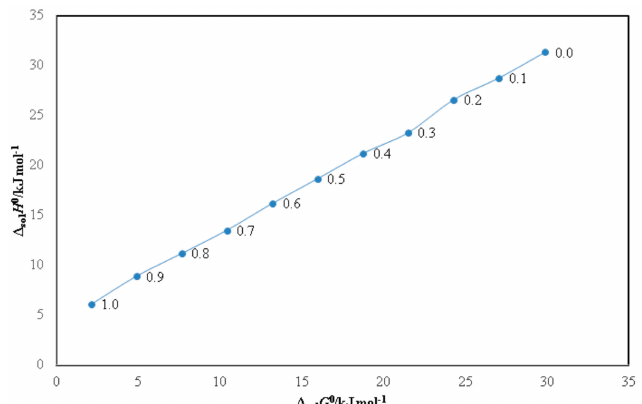
Figure 3. ∆ sol H 0 vs. ∆ sol G 0 enthalpy–entropy compensation plot for solubility of PPD in binary DMSO + water mixtures at T hm of 308 K.